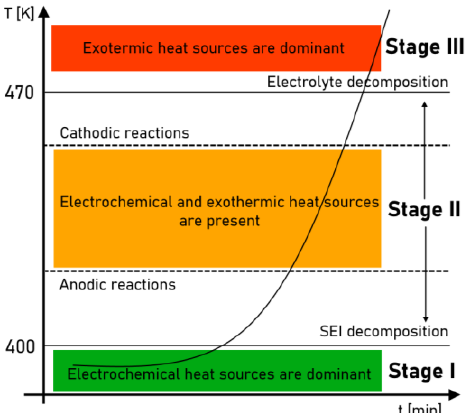
Figure 1. Critical stages that lead to the occurrence of the TR